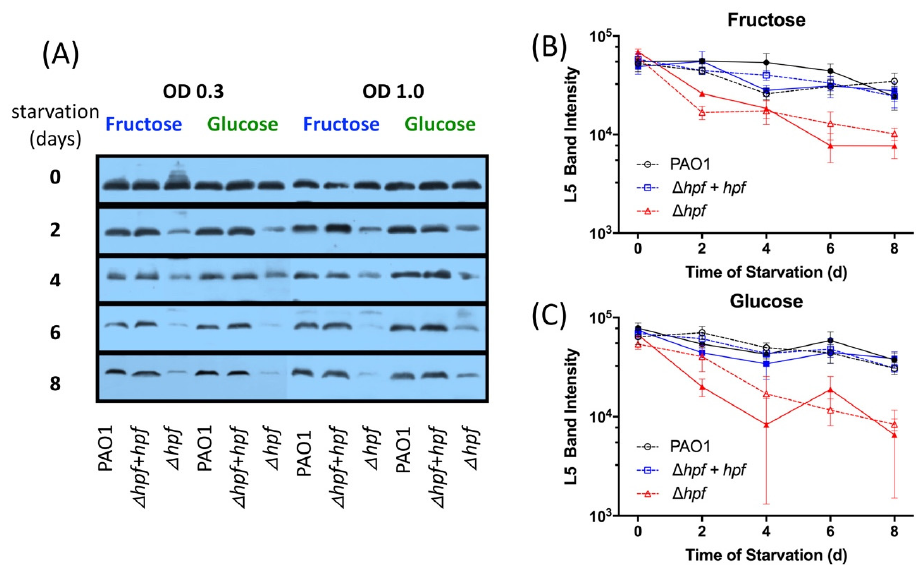
Figure 8. Quantification of P. aeruginosa L5 band intensity over the course of 8 d of starvation, from whole cell extracts. Strains were pre-cultured in MOPS minimal media to early exponential phase (O.D. 600 = 0.3 or 1.0) with either fructose or glucose as the sole carbon source. ( A ) Representative immunoblot of L5 from whole cell extracts. ( B ) Quantification of L5 signal intensity obtained by densitometry of three immunoblots, when strains were cultured in MOPS-fructose. Solid lines and symbols indicate cells were pre-cultured to O.D. 600 = 1.0 and dashed lines and open symbols indicate cells were pre-cultured to O.D. 600 = 0.3. ( C ) Quantification of L5 signal intensity when strains were cultured in MOPS- glucose. Data show the mean and standard error of three independent biological replicates.